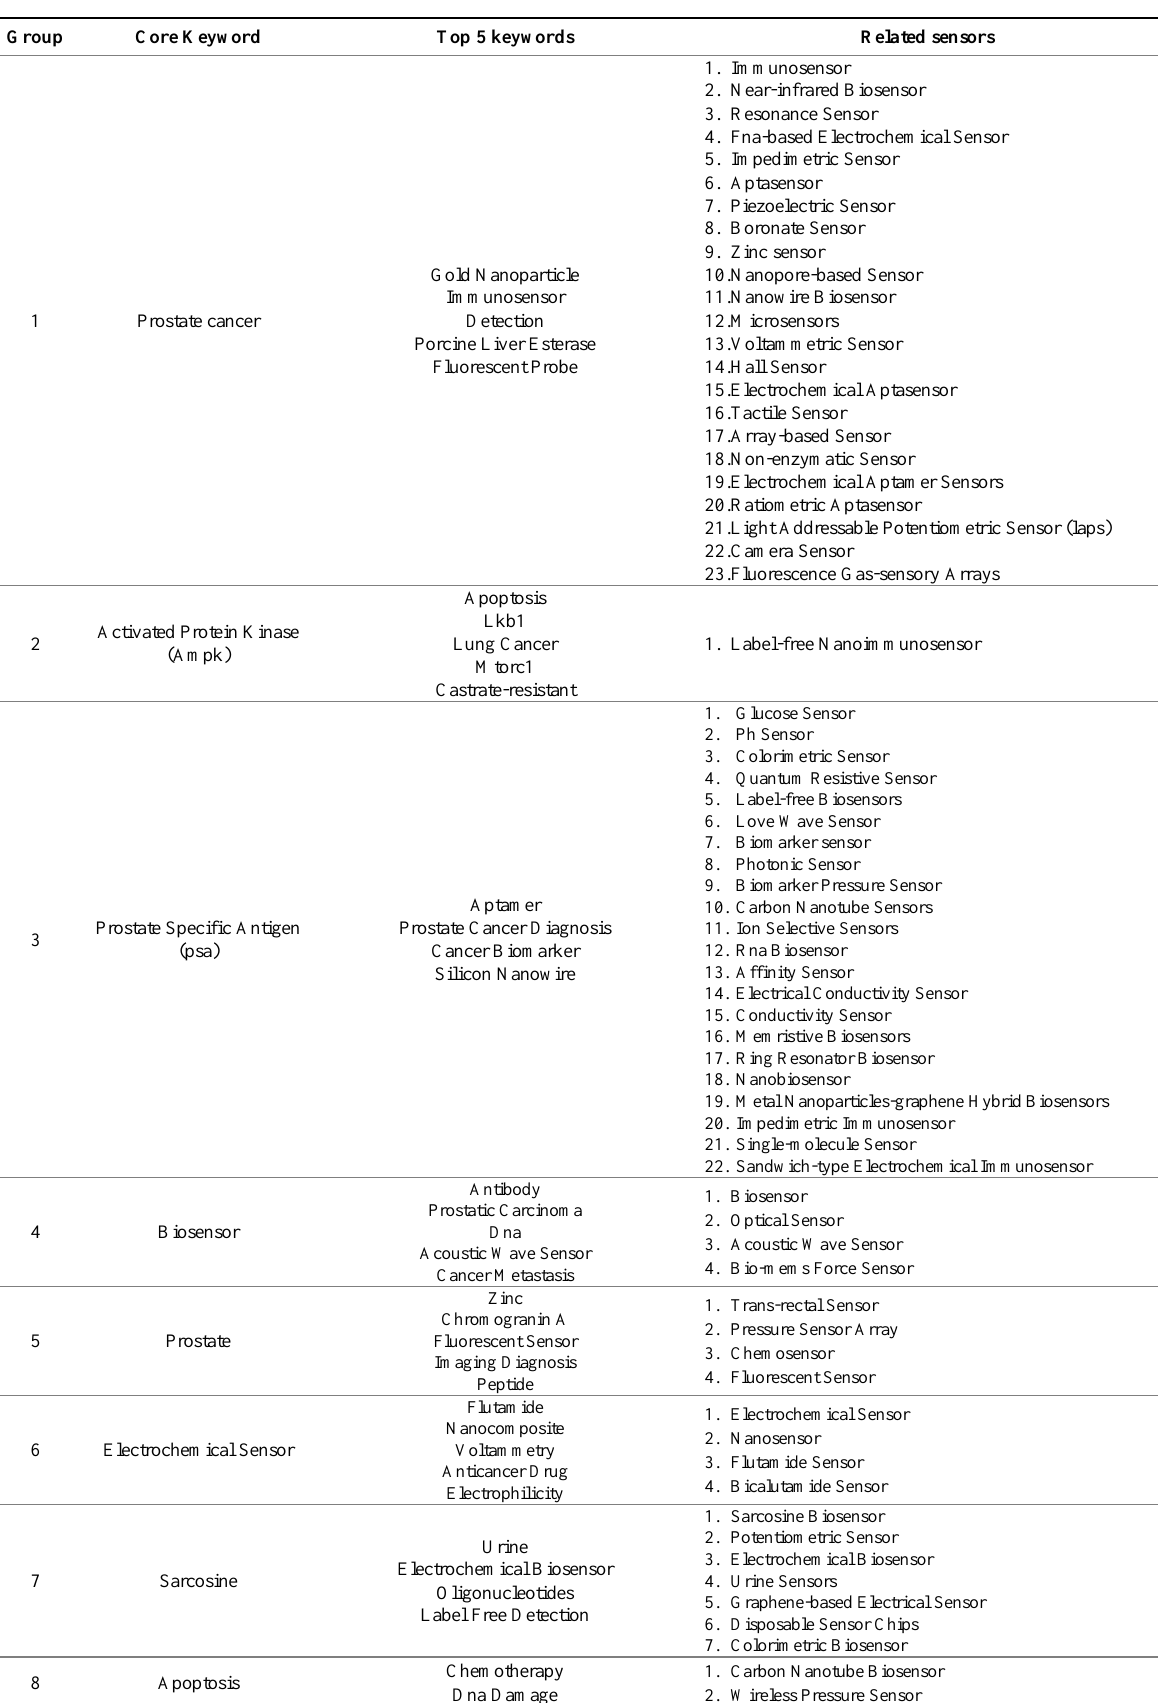
Table 3A. Groups, Core keywords and related sensors in the Prostate cancer network